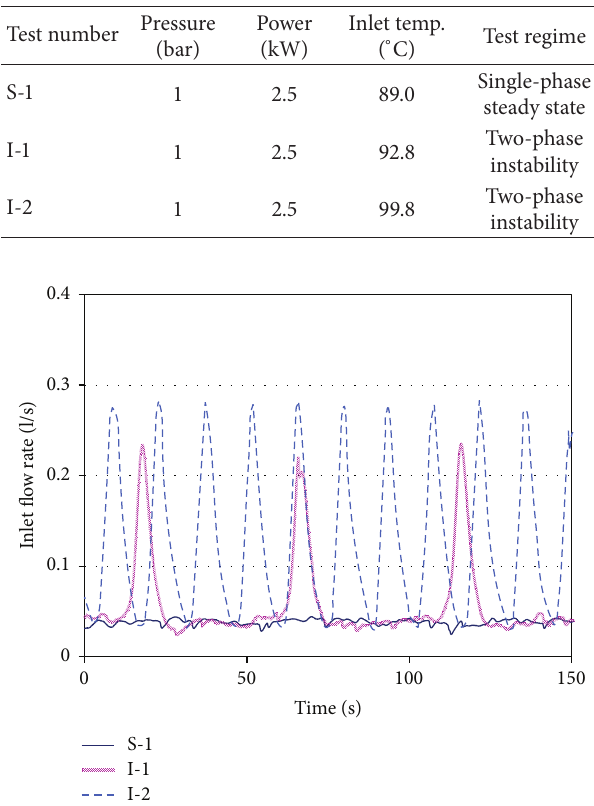
Table 1: Test conditions and regimes.